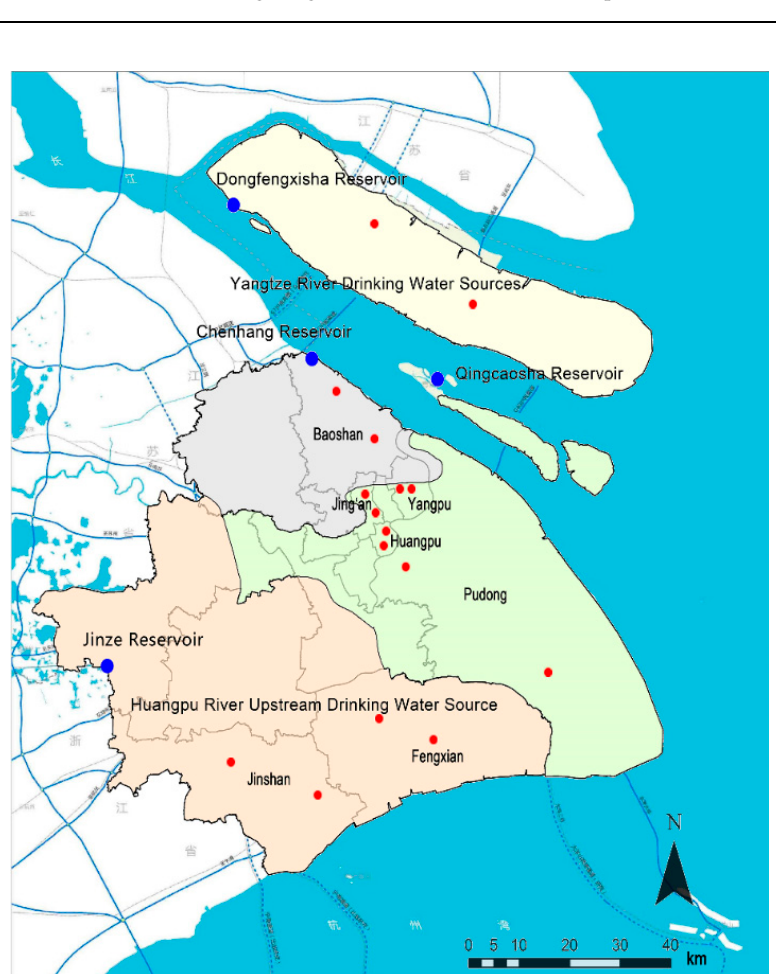
Figure 1. Distribution of sampling points. Table 1. The deployment of sampling points for end-of-pipe water in Shanghai.